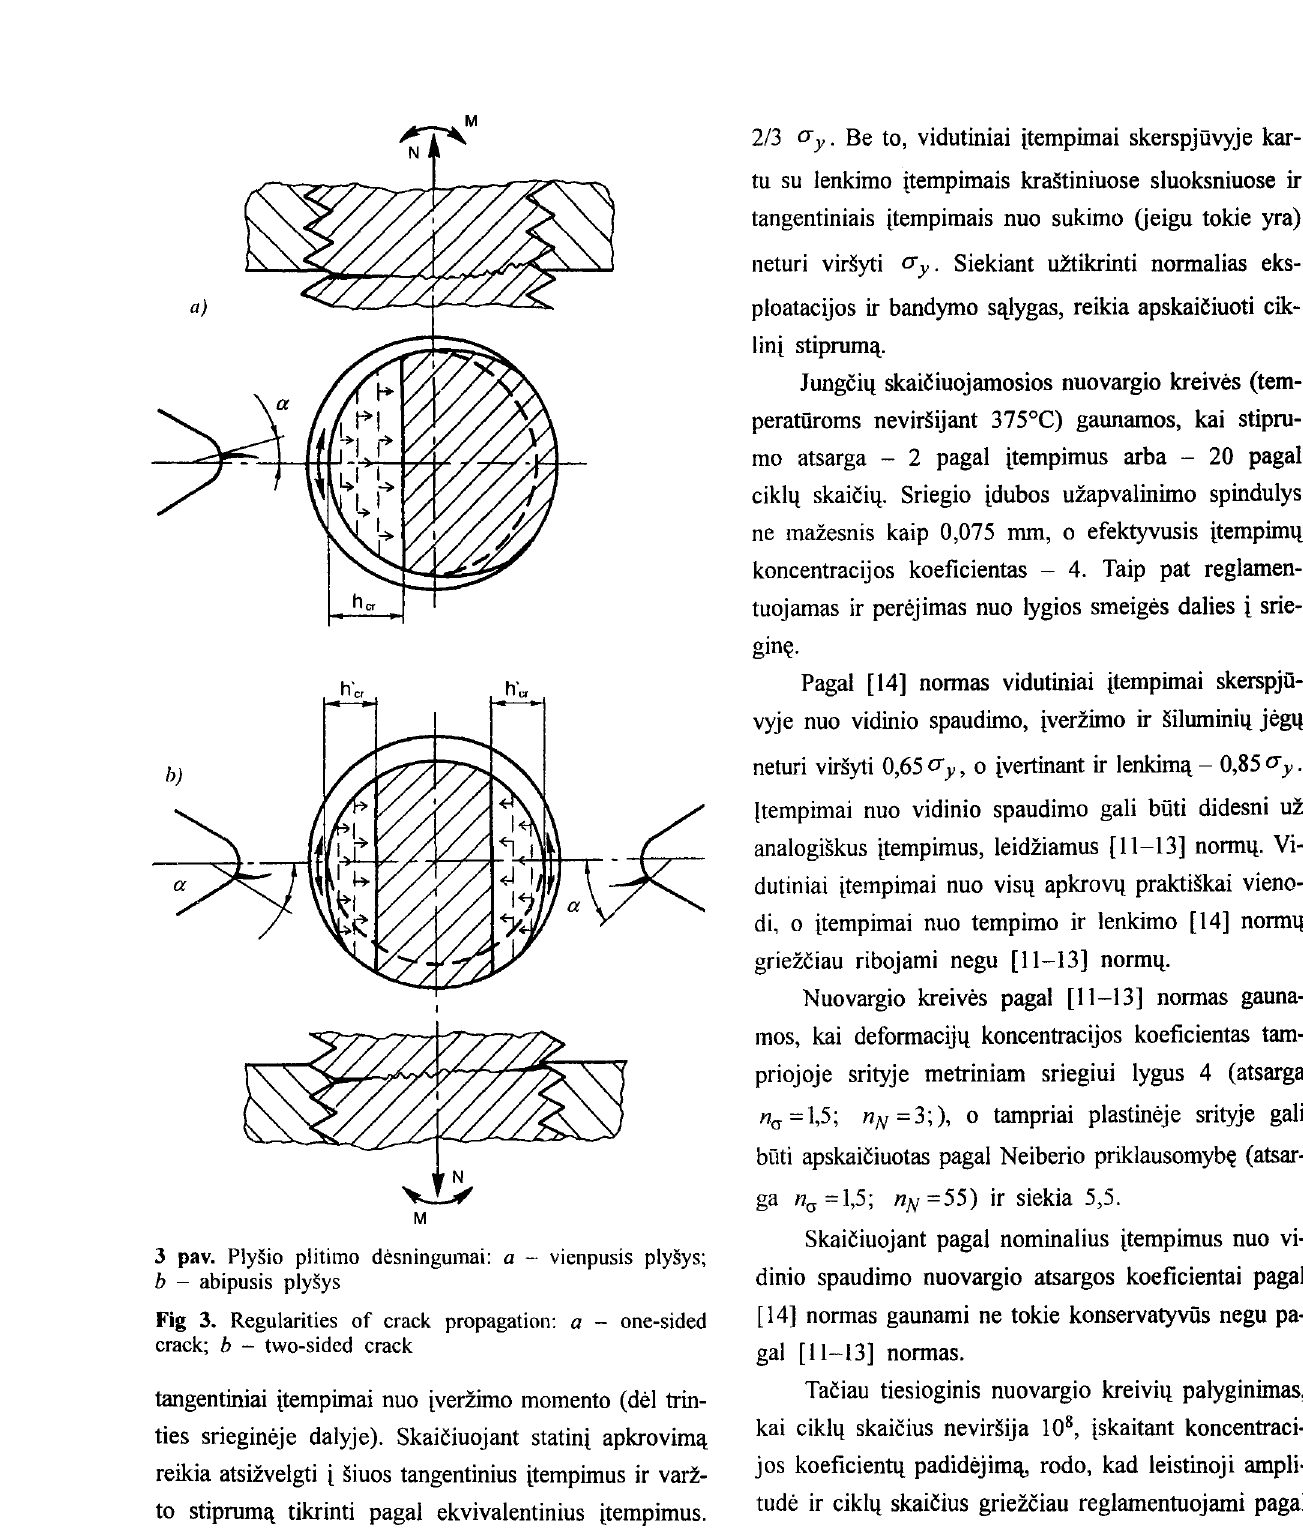
Fig 3. Regularities of crack propagation: a - one-sided crack; b - two-sided crack tangentiniai itempirnai nuo iverzirno momento (del trin ties sriegineje dalyje). SkaiCiuojant statini